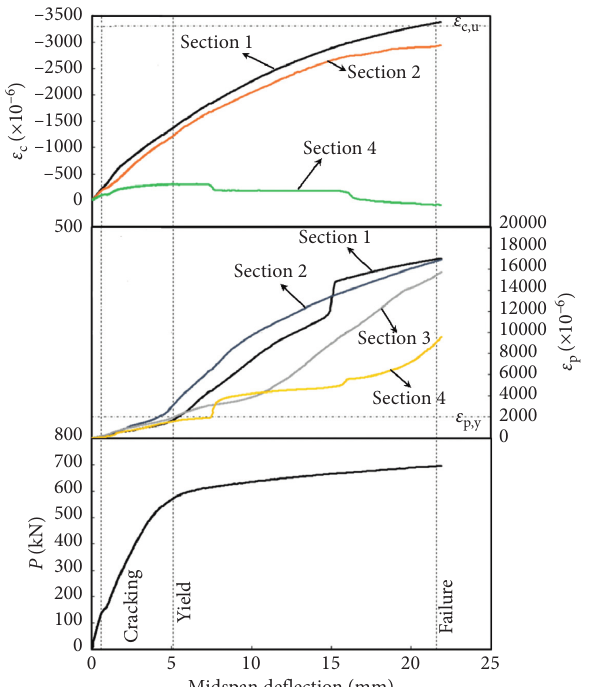
Figure 18: Load ( P ) and the longitudinal strain of concrete ( ε c ) as well as steel faceplate ( ε p ) versus midspan deflection curves for HSC2-3.